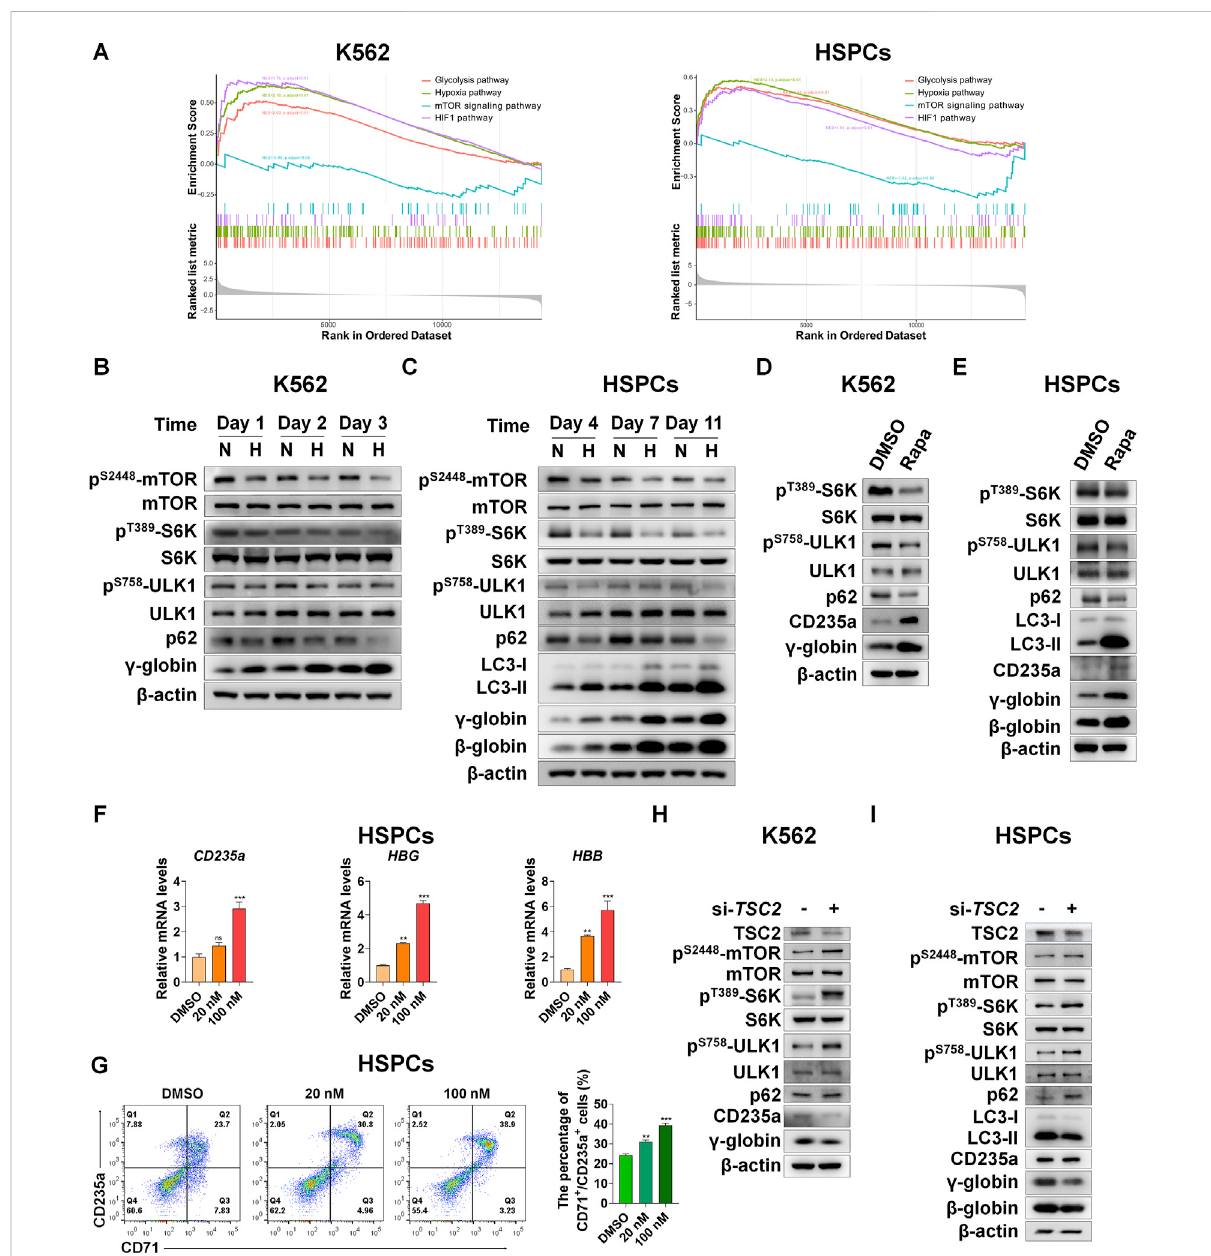
FIGURE 4 Suppression of mTORC1 is required for inducing autophagy and accelerating erythroid differentiation under hypoxia (A) After K562 cells (left) and HSPCs (right) differentiated erythrocytes were exposed to normoxia or hypoxia for 3 day and 7 days, respectively, RNA-seq was performed, and then GSEA was used to analyze the major pathways related to hypoxia. NES, normalized enrichment score (B,C) Western blot shows the effects of hypoxia on p62, LC3, γ -globin or β -globin protein levels and mTORC1 activity at different time points in the process of erythroid differentiation of K562 cells or HSPCs (D,E) Western blot analysis of the effects of Rapa (100 nM) on p62, LC3, CD235a, γ -globin or β -globin protein levels and mTORC1 activity in K562- or HSPCs-differentiated erythrocytes under normoxia (F) qRT-PCR analysis of the relative mRNA levels of CD235a, HBG and HBB after HSPCs were differentiated into erythrocytes which were treated with DMSO or different concentrations of Rapa for 3 days from the fourth day to the seventh day of differentiation under normoxia. ns, not signi fi cant, ** p < 0.01, *** p < 0.001, versus the DMSO group (G) Flow cytometryplotsshowtheexpressionofCD235aandCD71inHSPCs-differentiatederythrocytestreatedthesameas (F) .Thegraphontherightshows the percentage of CD71 + /CD235a + cells. ** p < 0.01, *** p < 0.001. versus the DMSO group (H,I) Western blot analysis of the effects of TSC2knockdownonp62,LC3,CD235a, γ -globinor β -globinproteinlevelsandmTORC1activityinK562cells-orHSPCs-differentiatederythrocytes under